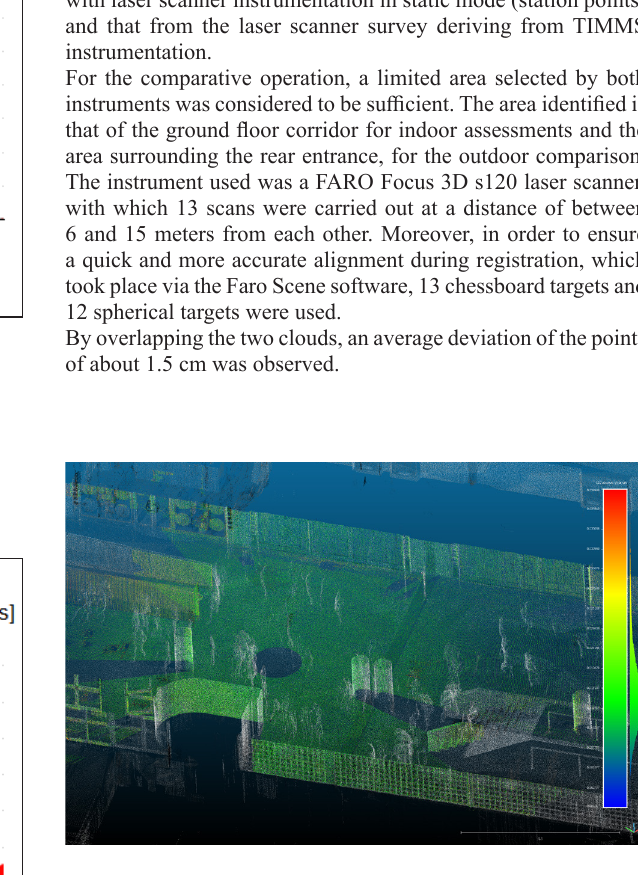
Figure 23. Elaboration of indoor TIMMS/FARO cloud deviation